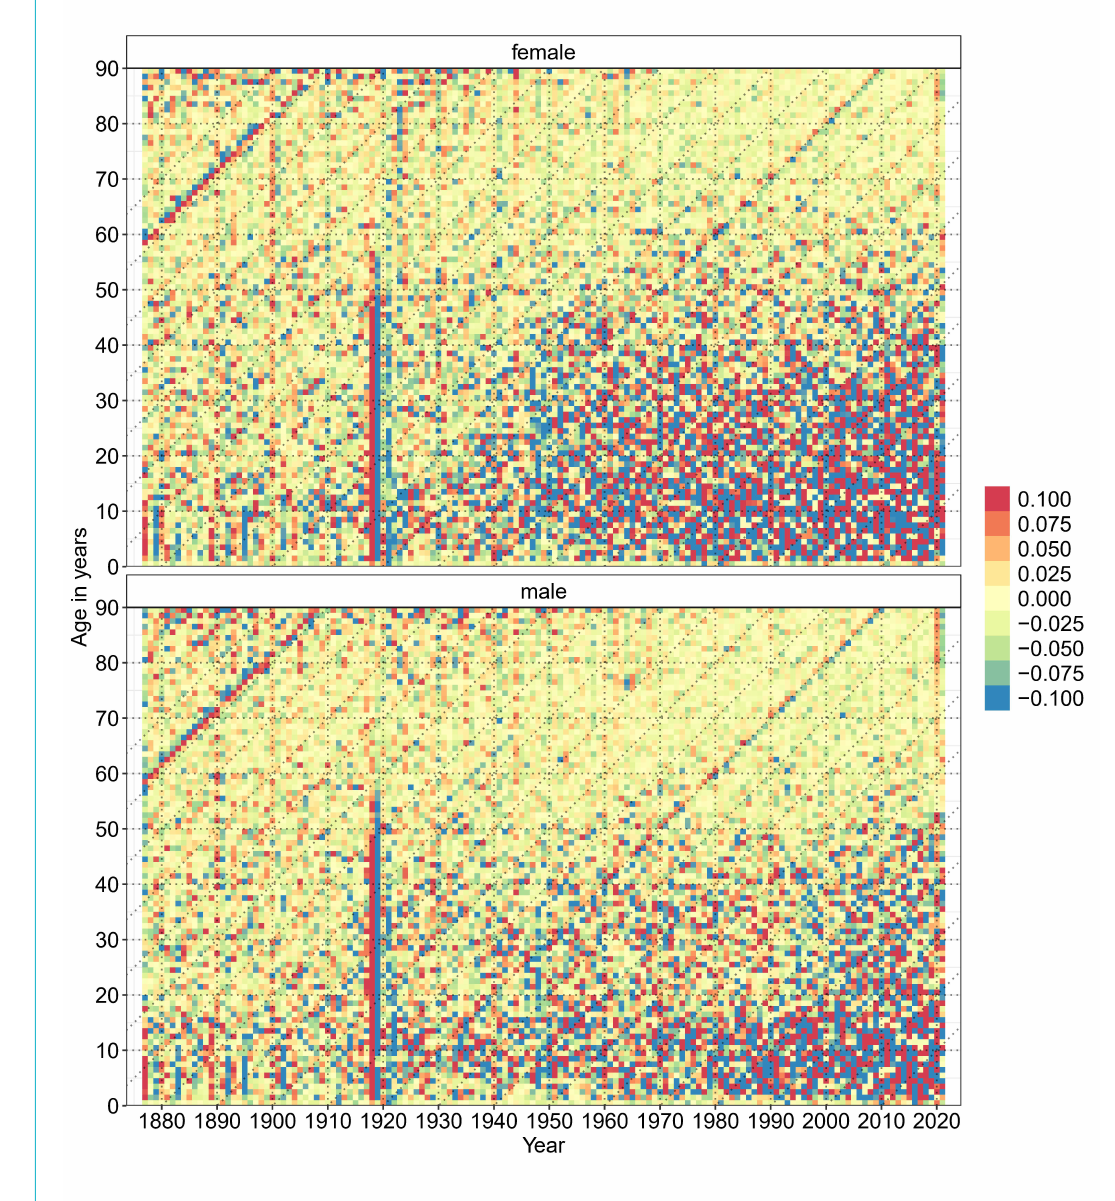
Figure 1: Lexis surface plot (adapted to Swiss data from Jones et al. [20]) for annual change in age-specific mortality. Orange and red repre- sent an increase in mortality compared with the previous year, while blue and green represent decreased mortality. Vertical lines represent pe- riod effects, while diagonal lines represent cohort